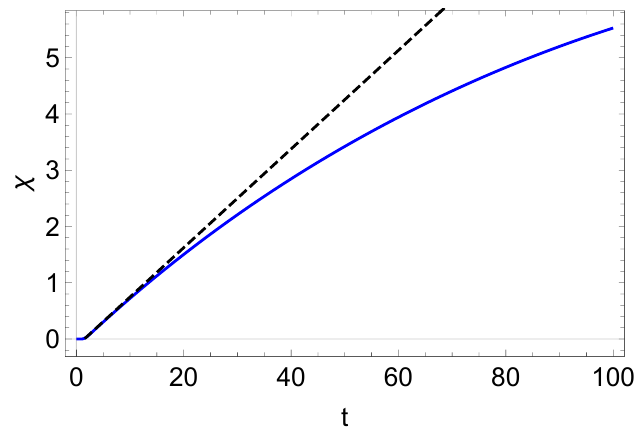
Figure 11 . Boundary scalar field χ as a function of time for β = 0 . 1 and initial conditions given by (4.16). We see that χ slowly saturates to a constant